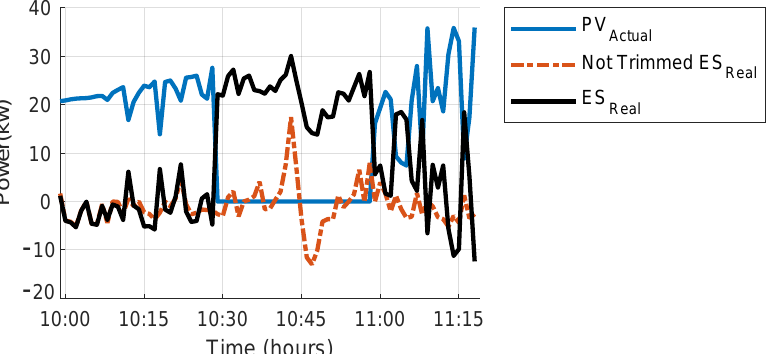
Figure 16. Scenario 3—battery and building load